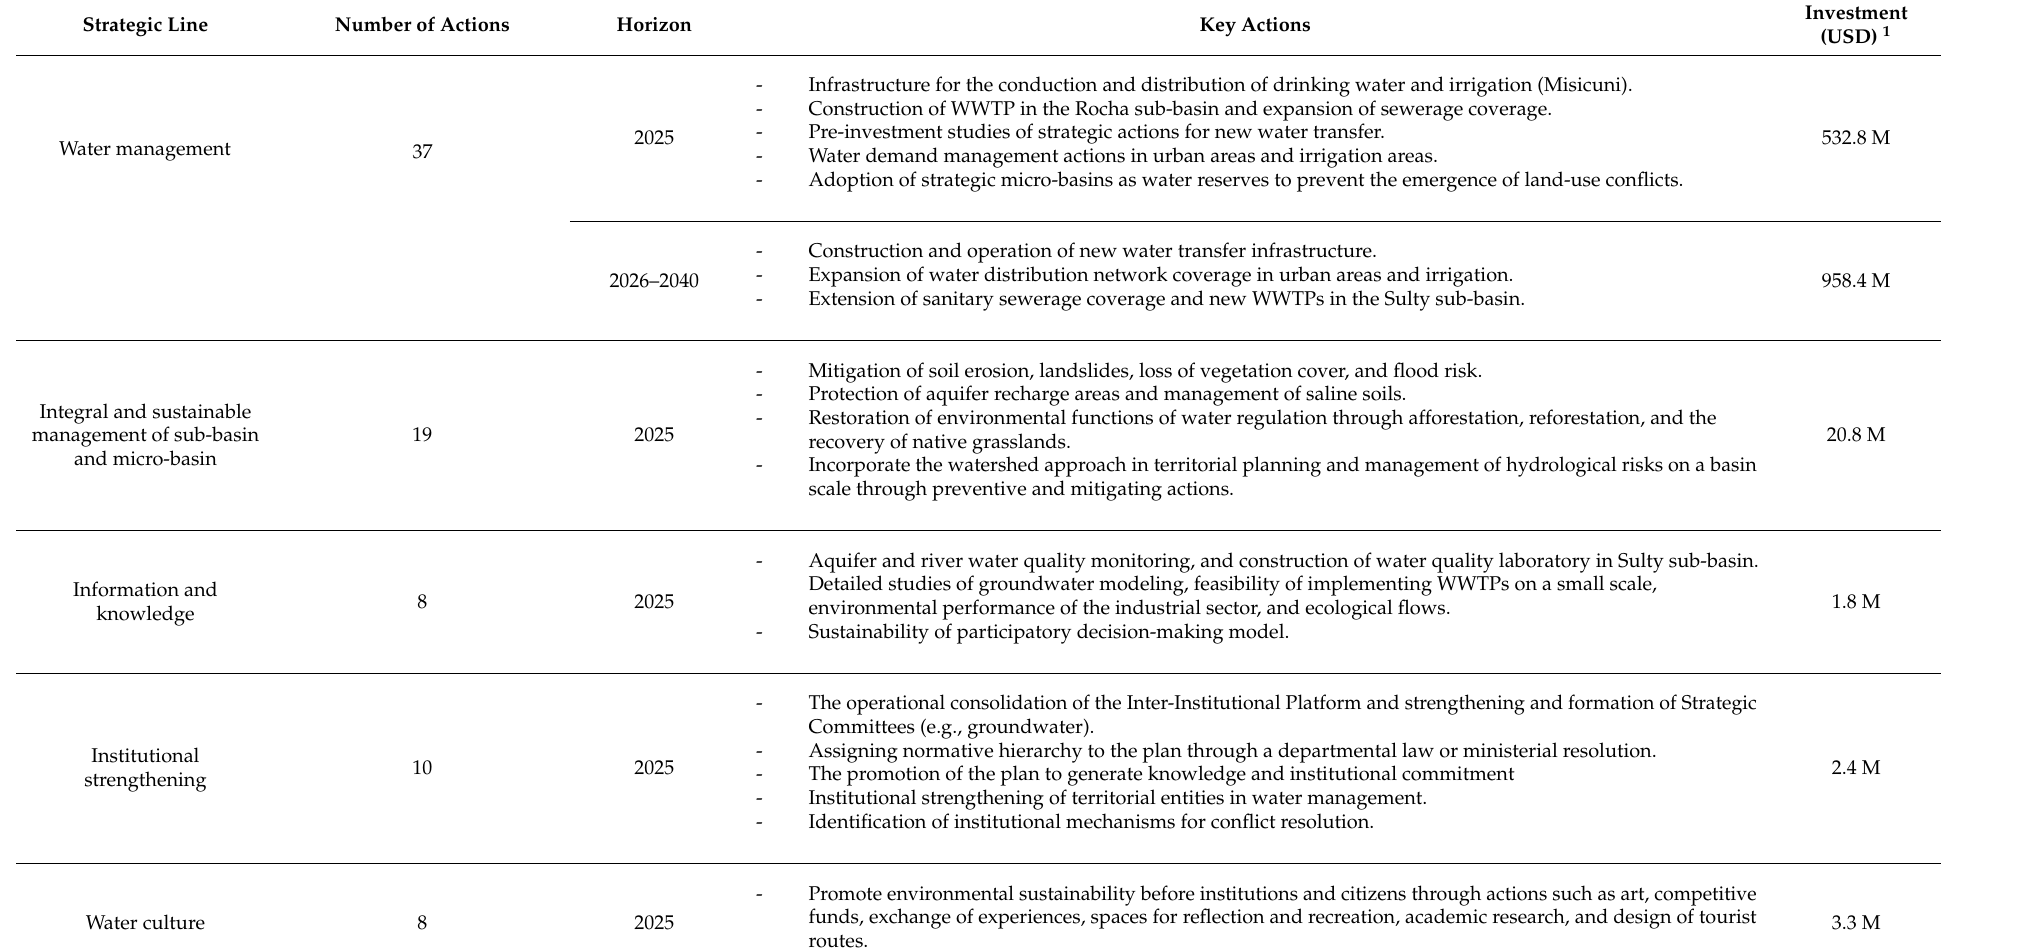
Table 4. Summary of the Rocha River Basin master plan agreed with the Inter-Institutional